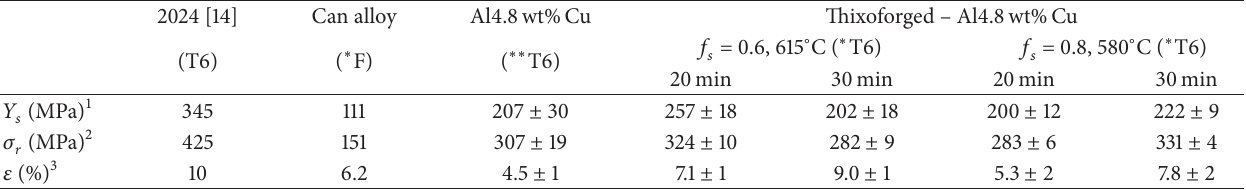
Table 2: Results of the tensile tests.